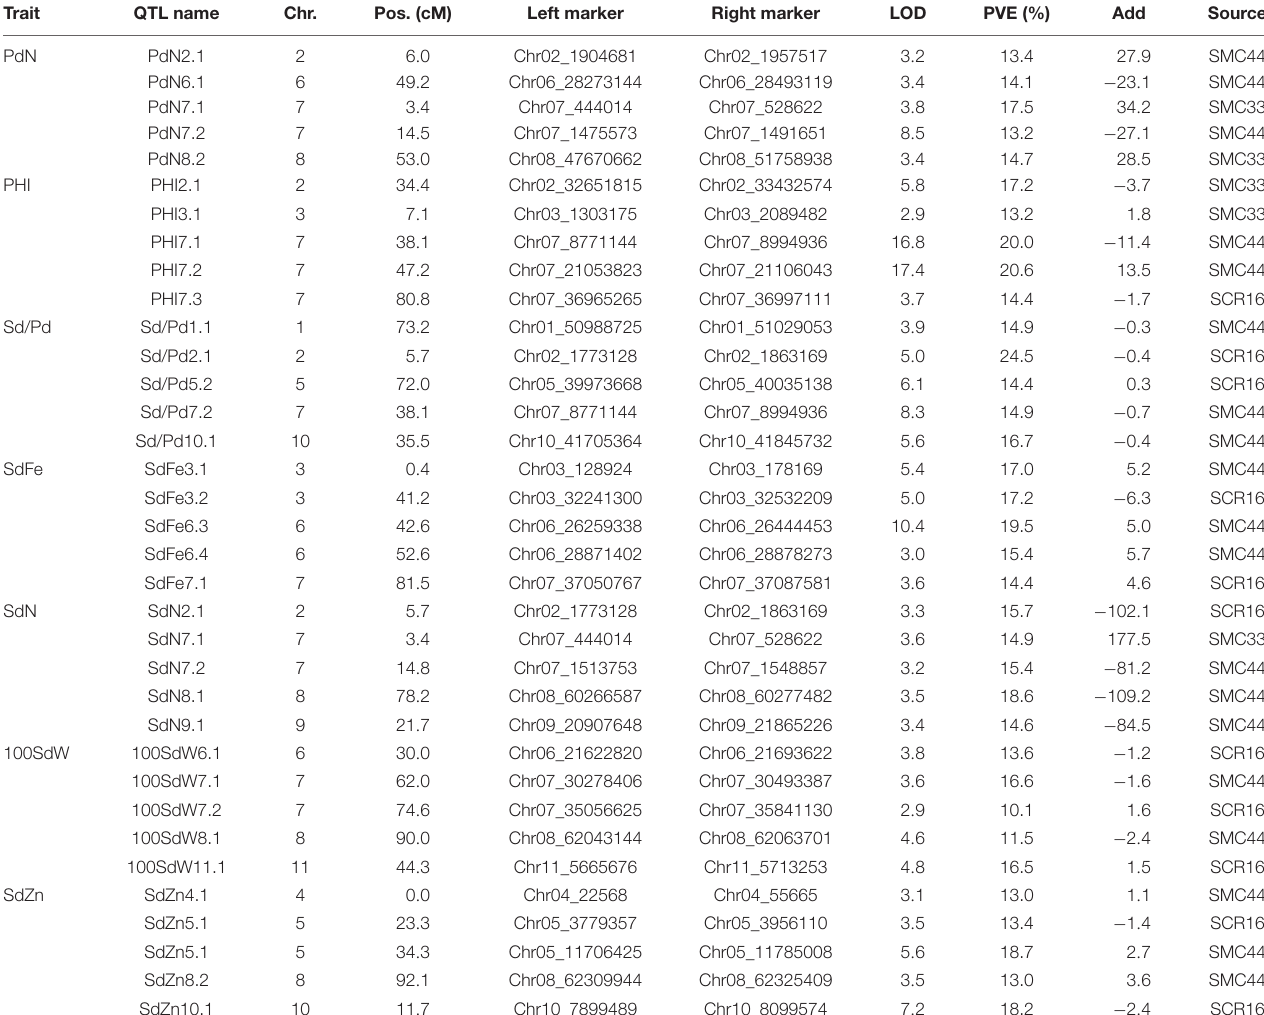
TABLE 2 | Five most important “major QTLs” identified by inclusive composite interval mapping for additive effects (ICIM-ADD), genetic and physical position, LOD, phenotypic variation explained and additivity, mapped for SdFe, seed iron; SdZn, seed zinc; PHI, pod harvest index; PdN, pod number; SdN, seed number; Sd/Pd, number of seeds per pod in SCR16 × SMC40, SMC33 × SCR16, and SMC44 × SCR9 populations evaluated in 2011, 2012, 2013, 2014, and 2015.